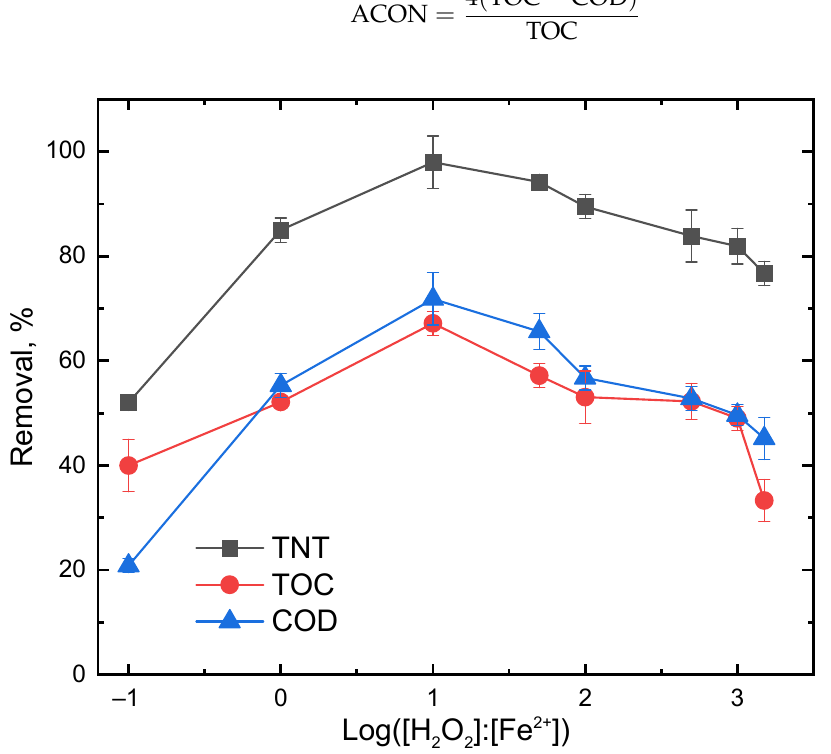
Figure 3. Effect of H 2 O 2 to Fe 2+ molar ratio on the removal of TNT, TOC and COD. Experimental conditions: (TNT) 0 = 30 mg/L, (Fe 2+ ) = 5 × 10 − 4 M, Initial pH = 3.0 ± 0.1, (NaCl) = 10 − 2 M, US intensity = 8571 W/m 3 , Temperature = 25 °C, Reaction time = 60 min.